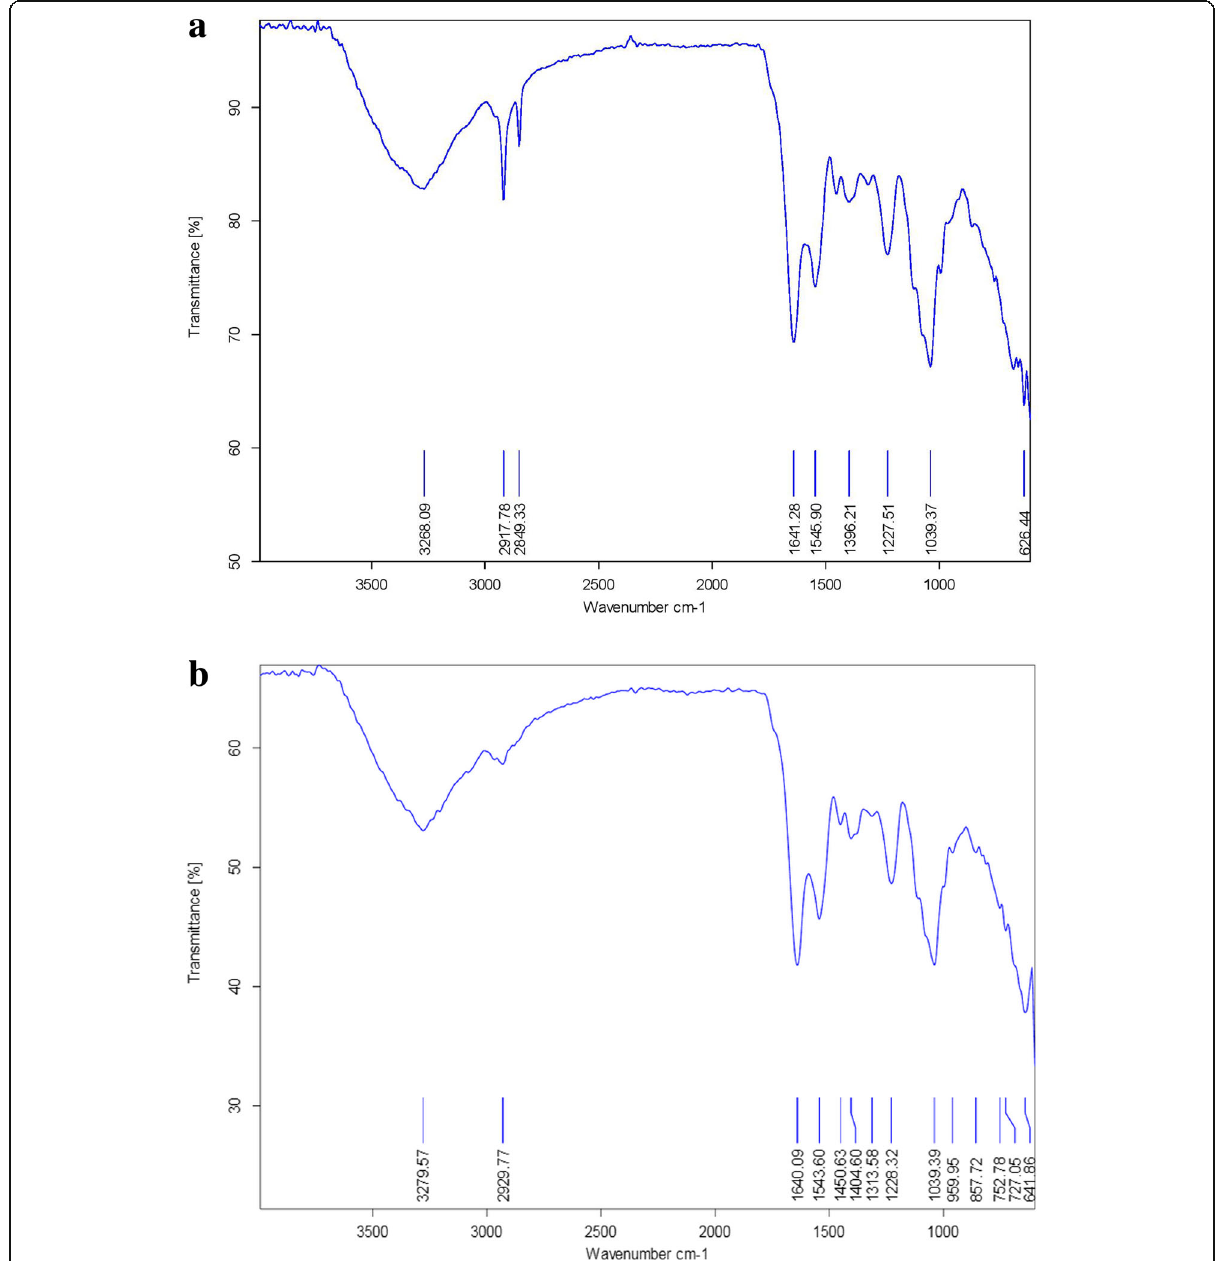
Fig. 3 IR spectra of Lactococcus lactic subsp. lactis cells grown in the presence ( a ) and absence ( b ) of